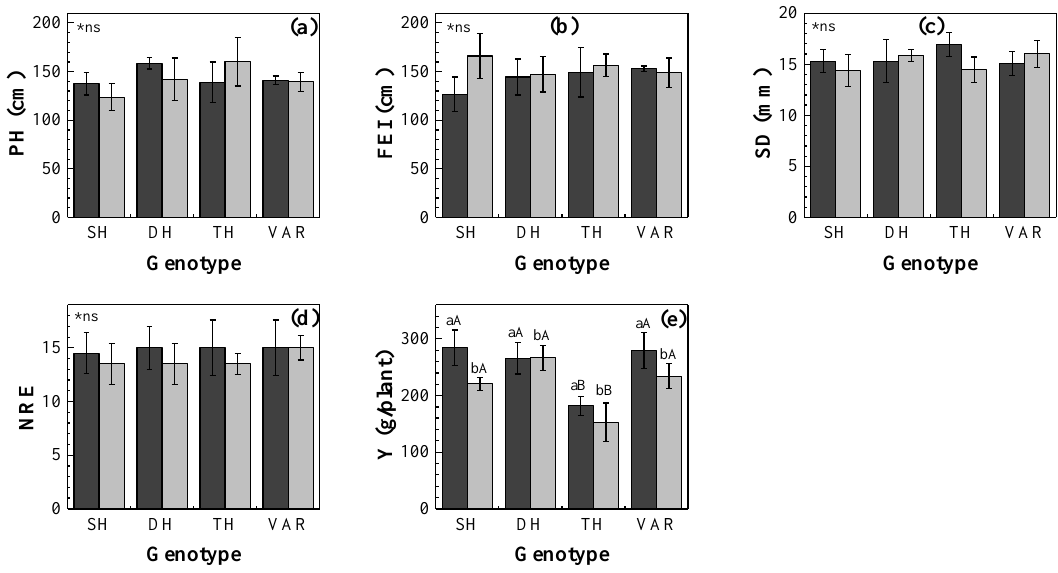
Figure 2. Impact of water-deficit stress on the four maize genotypes under study in the 11–20 DAE (days after emergence) period: ( a ) plant height (PH, cm); ( b ) height of the first ear insertion (FEI, cm); ( c ) stem diameter (SD, mm); ( d ) number of rows per ear (NRE); and ( e ) yield per plant (Y, g · plant − 1 ). Dark grey bars and light grey bars correspond to without water restriction (WWR) and water restriction (WR) conditions, respectively. Averages followed by the same uppercase or lowercase do not differ by Tukey test at 5% probability. Lowercase letters compare the values of water regimes (WWR vs. WR) and capital letters compare values among genotypes. The bars represent the mean standard deviations. *ns = not significant.